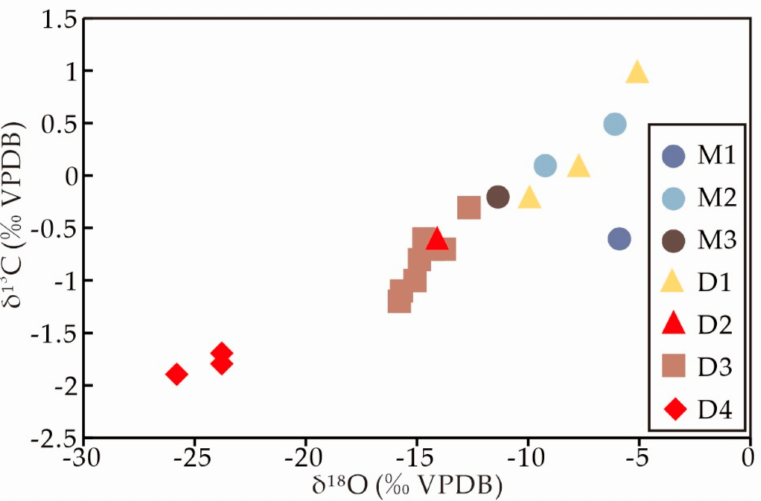
Figure 7. Stable isotope values for the dolomites of the Lower Paleozoic strata in the Dongying Depression, Bohai Bay Basin. M1: argillaceous dolomite; M2: microcrystalline dolomite; M3: fine- crystalline dolomite; D1: powder-to-fine-crystalline dolomite cement; D2: fine-crystalline ferroan dolomite cement; D3: medium-to-coarse-crystalline dolomite cement; D4: saddle